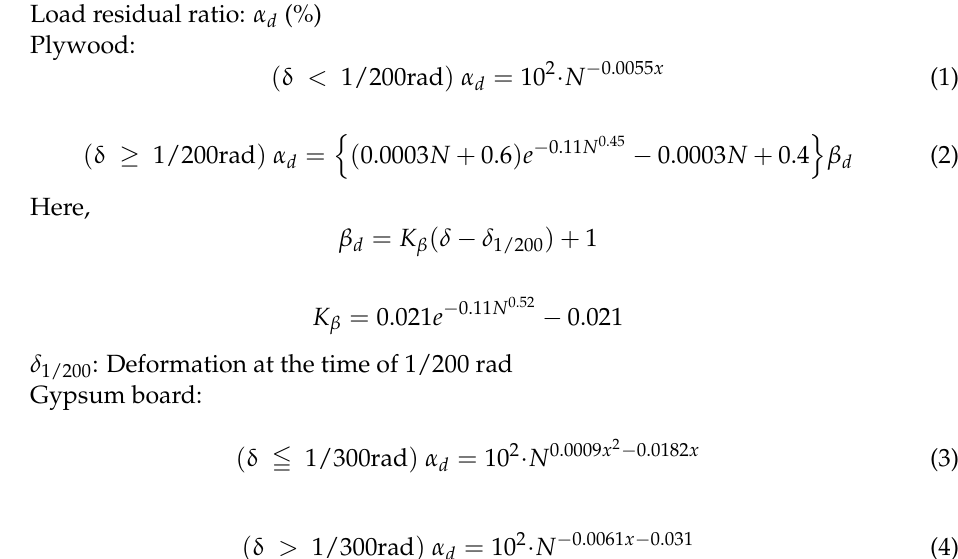
Figure 8. Comparison between estimated value and test result of load residual ratio. (Gypsum board) Solid line: prediction; dotted line: test result.